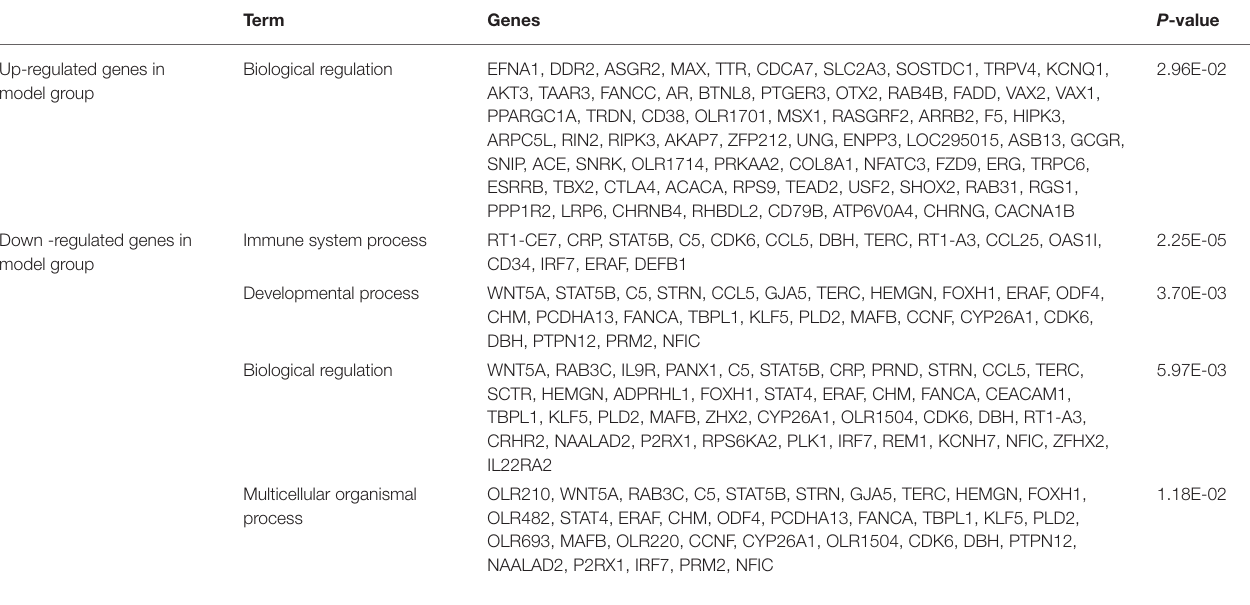
TABLE 1 | Classification of the upregulated and downregulated genes involved in the significant bioprocesses of the model group compared with the control